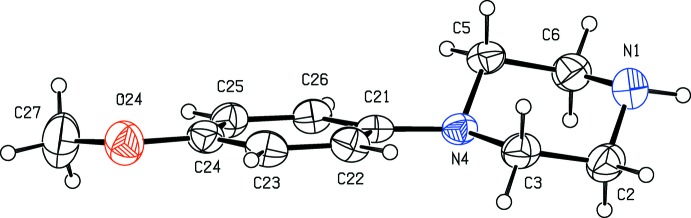
The mol­ecular structure of compound (I) showing the atom-labelling scheme. Displacement ellipsoids are drawn at the 30% probability level.